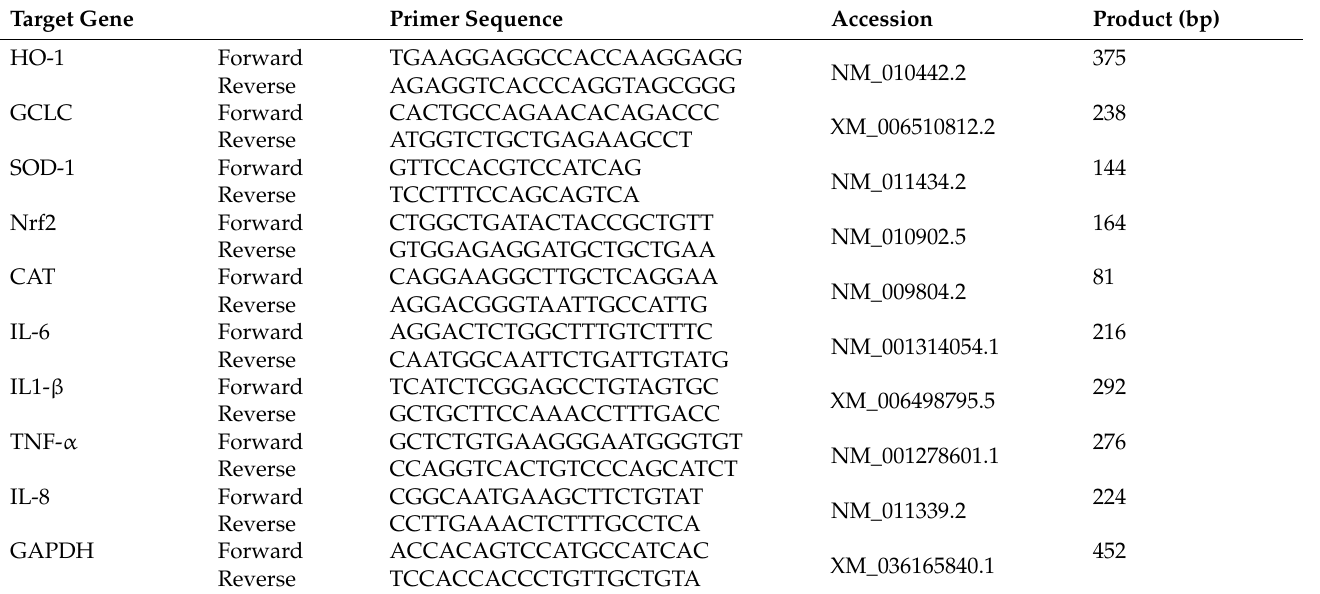
Table 1. PCR Primers Used for the Quantification of the Candidate Genes in mice.